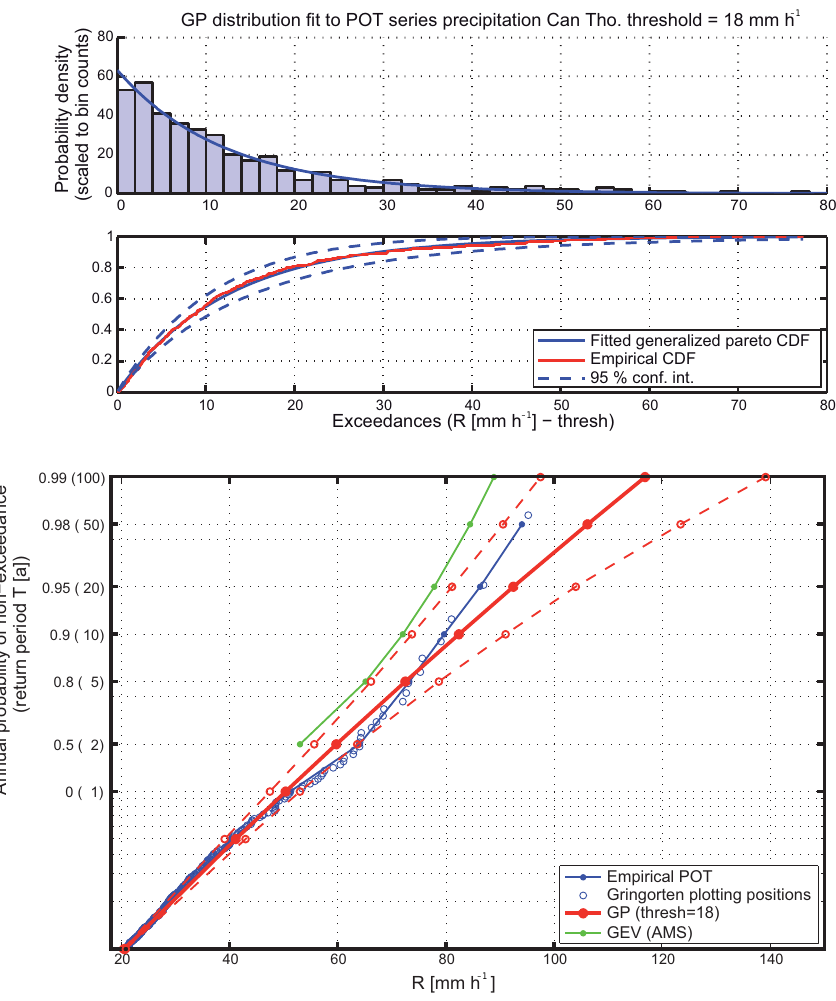
Figure 9. Fit of the GP to the hourly rainfall time series of Can Tho with POT threshold = 18mmh − 1 . The lower figure shows the fitted GP distribution with 95% uncertainty bounds, the empirical POT distribution and the plotting positions for the POT series, along with a GEV distribution fitted to the annual maxima series for comparison.